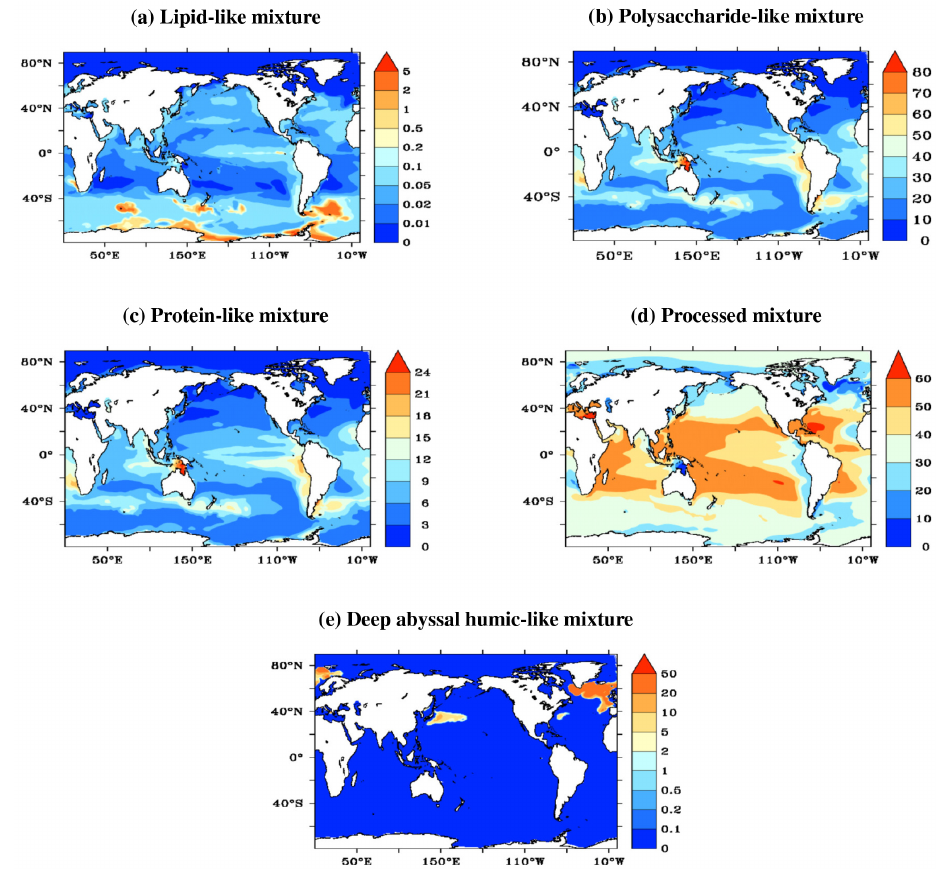
Figure 6. Ocean surface concentration of each compound class (µmolL − 1 ) in February. Ocean concentrations for May, August and Novem- ber are provided in the Supplement Figs. S1, S2, and